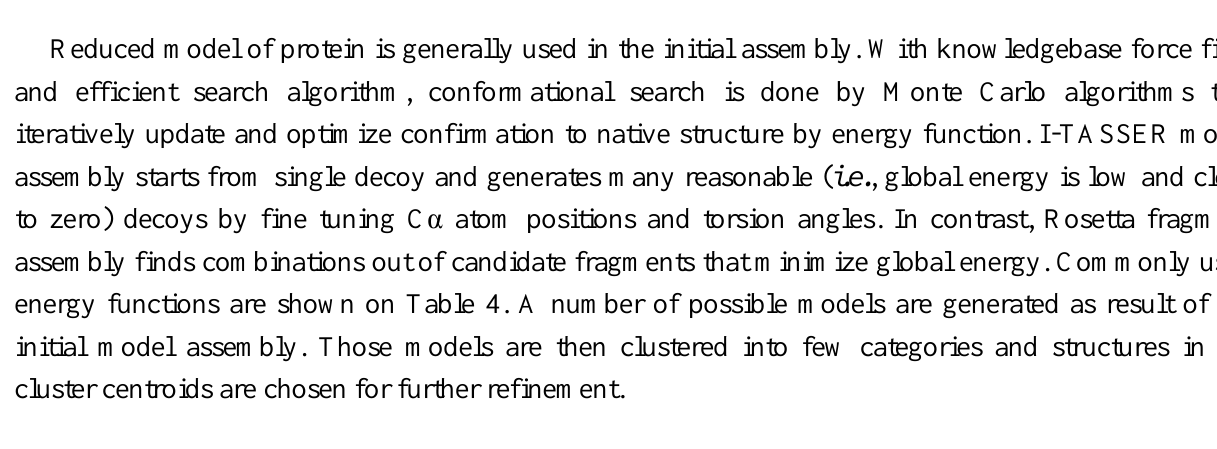
Table 4. Energy functions used in structure